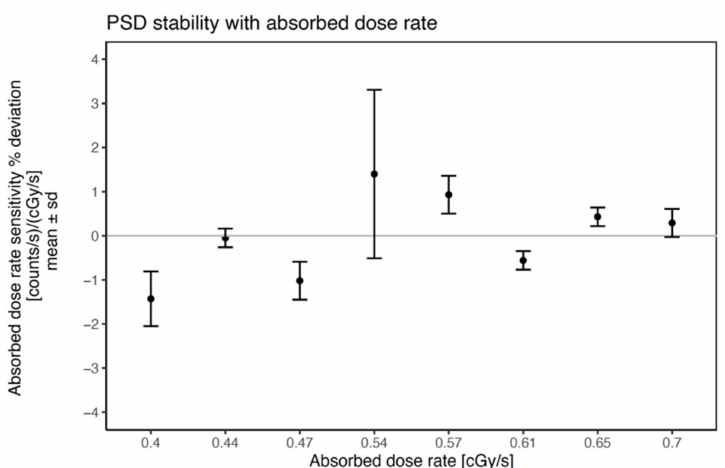
Figure 1. Absorbed dose rate sensitivity percent deviation as a function of absorbed dose rate. Sensitivity is the quotient between PSD count rate and the absorbed dose rate. The black dots indicate the mean value of three consecutive measurements. The error bars are based on standard deviation.